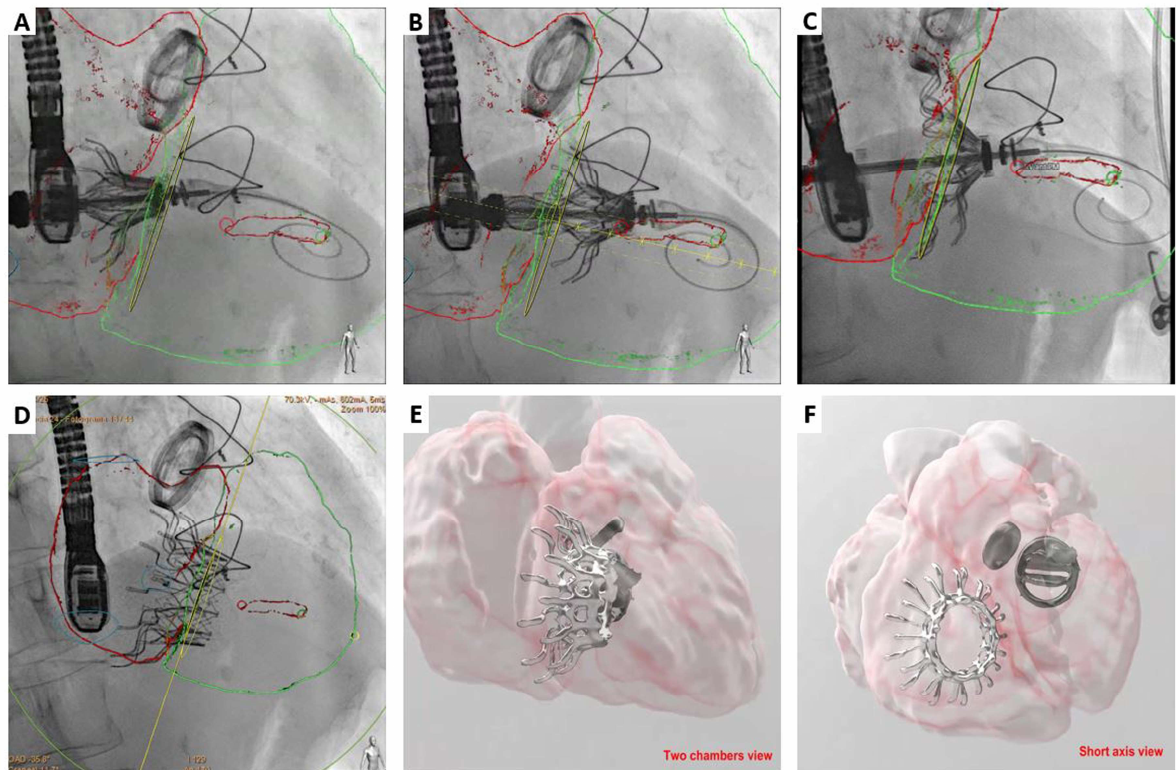
Figure 5. Cardiovalve TTVR case. Fluoroscopy-CT tomography fusion imaging during TTVR procedure. Leaflet grasping legs opened in the left atrium ( A ), and into the right ventricle in order to grasp tricuspid leaflets ( B ). Atrial flange released ( C ) and result after release the valve ( D ). Computed tomography 3D-segmentation 6 months after the procedure on a two-chambers view ( E ) and short axis view ( F ).